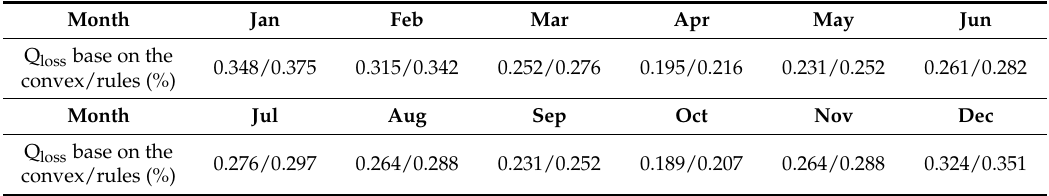
Table 7. The total battery degradation percentage in different month of the year.